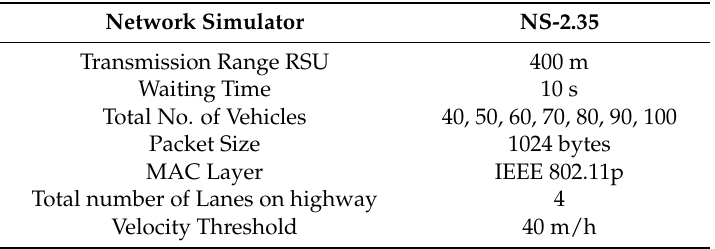
Table 3. Properties of the TARS simulation